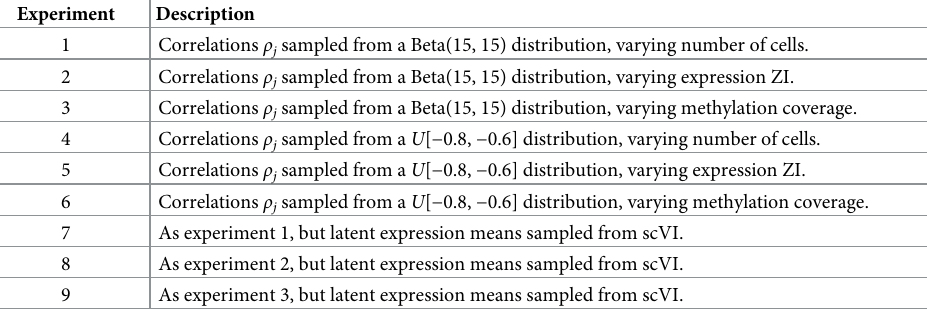
Table 1. Summary of synthetic data experiments. In all cases, latent means and standard deviations were set as μ j 1 = 4, μ j 2 = 1, σ j 1 = 3 and σ j 2 = 2. Unless otherwise stated, our simulations were based on: I = 60 cells, J = 300 features, 20% ZI rate on average for the expression data ( π = 0.20) and an average methylation coverage ( n ) equal to 275 (sampled j ij from a Uniform distribution with range [50, 500]) across cells and genes. When varying the number of cells, we use I 2 {5, 10, 25, 50, 100, 200, 400, 800, 1600}. When varying expression ZI, we use π 2 {0.1, 0.2, 0.3, 0.4, 0.5, 0.7, 0.8}. When j varying methylation coverage, we sample n ij from Uniform distributions with ranges given by [5, 10], [10, 20], [20, 50], [50, 250] and [500, 1000]. Full details are provided in S3 Text.